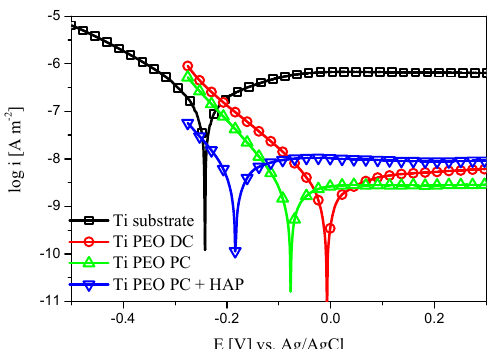
Figure 6. OCP measurements of the Ti-based samples for 600 s in Ringer’s solution at 37 °C.